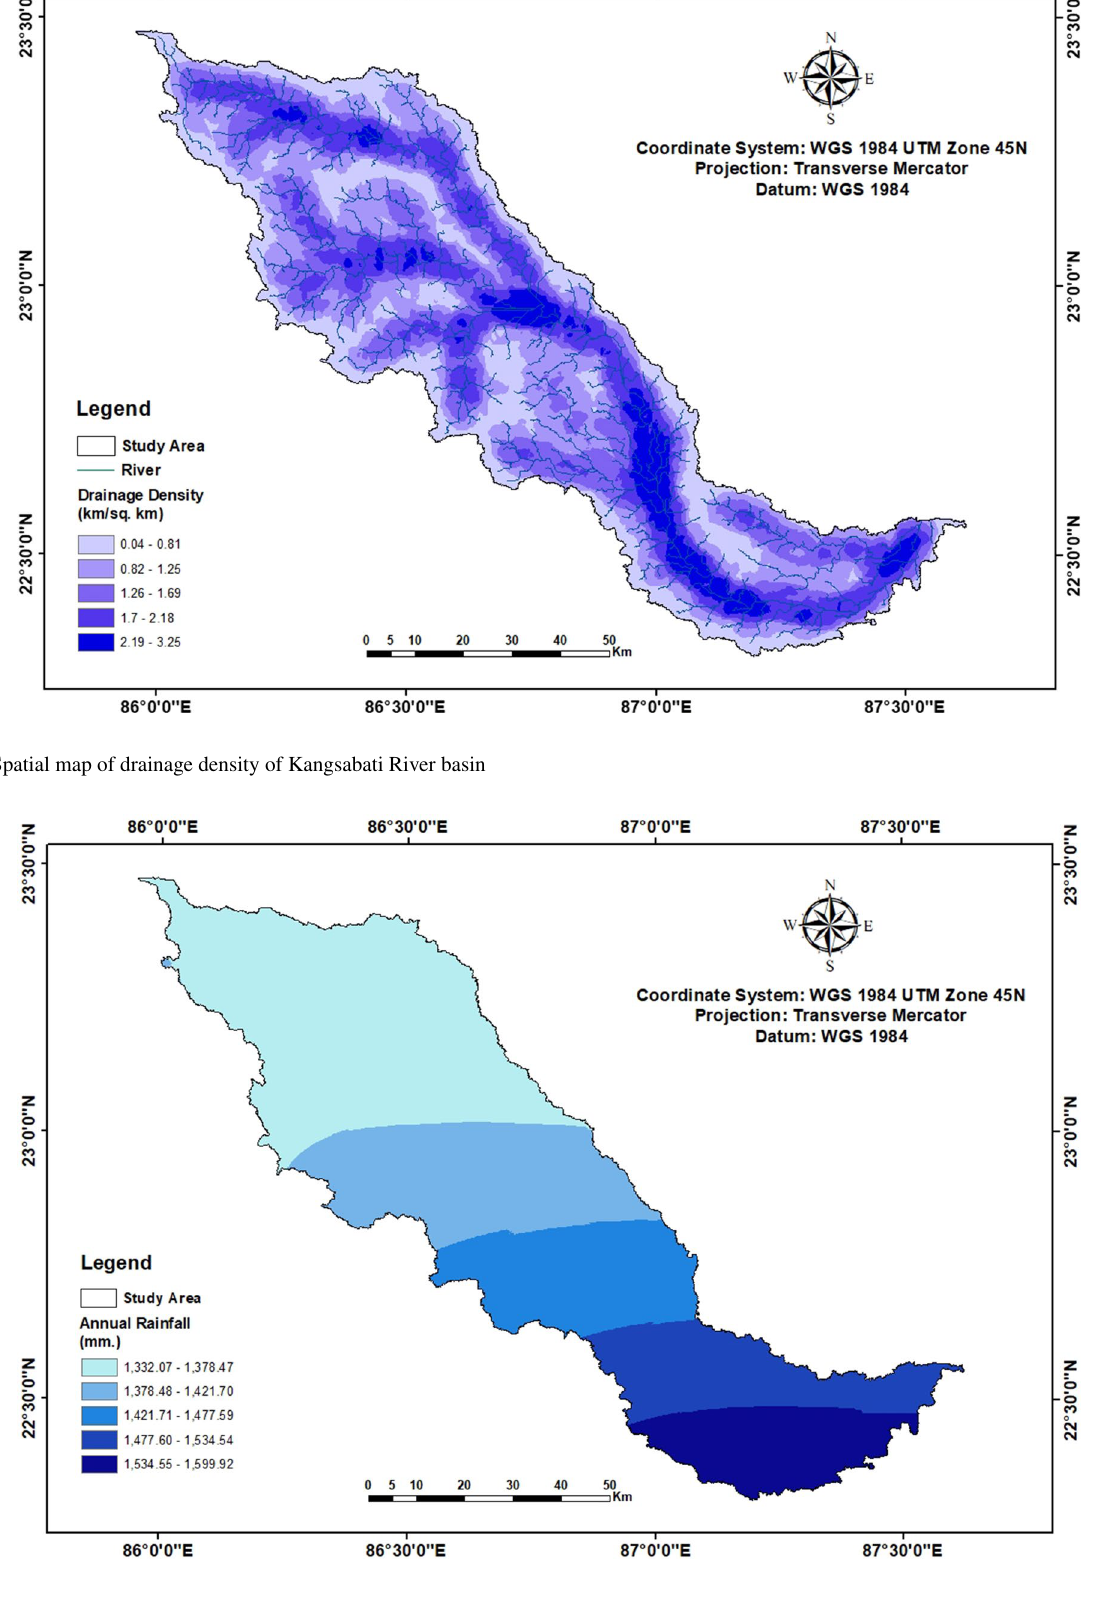
Fig. 10 Rainfall distribution map of Kangsabati River